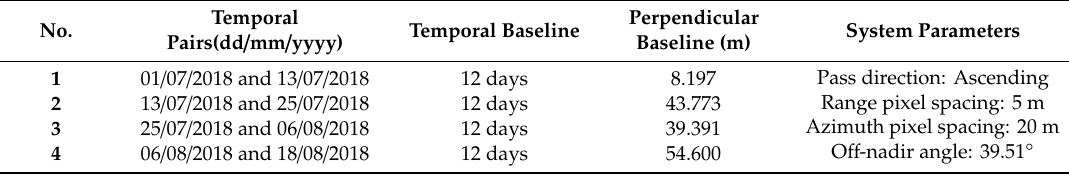
Table 1. List of temporal pairs of Sentinel-1A Interferometric Wide Swath (IW) mode data used for glacier movement estimation.